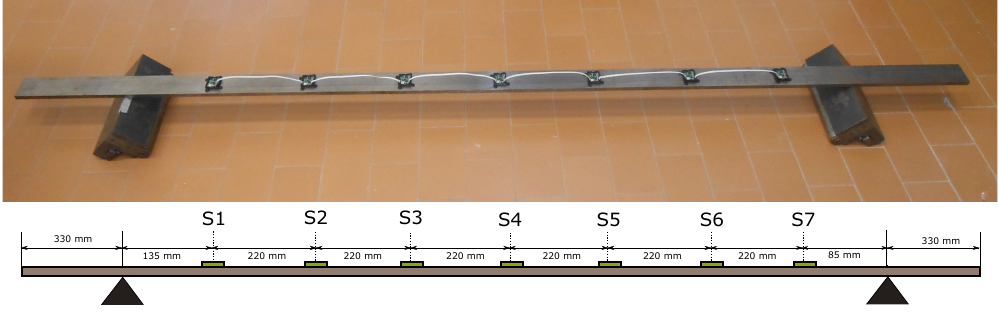
Figure 7. Experimental setup in vibrating